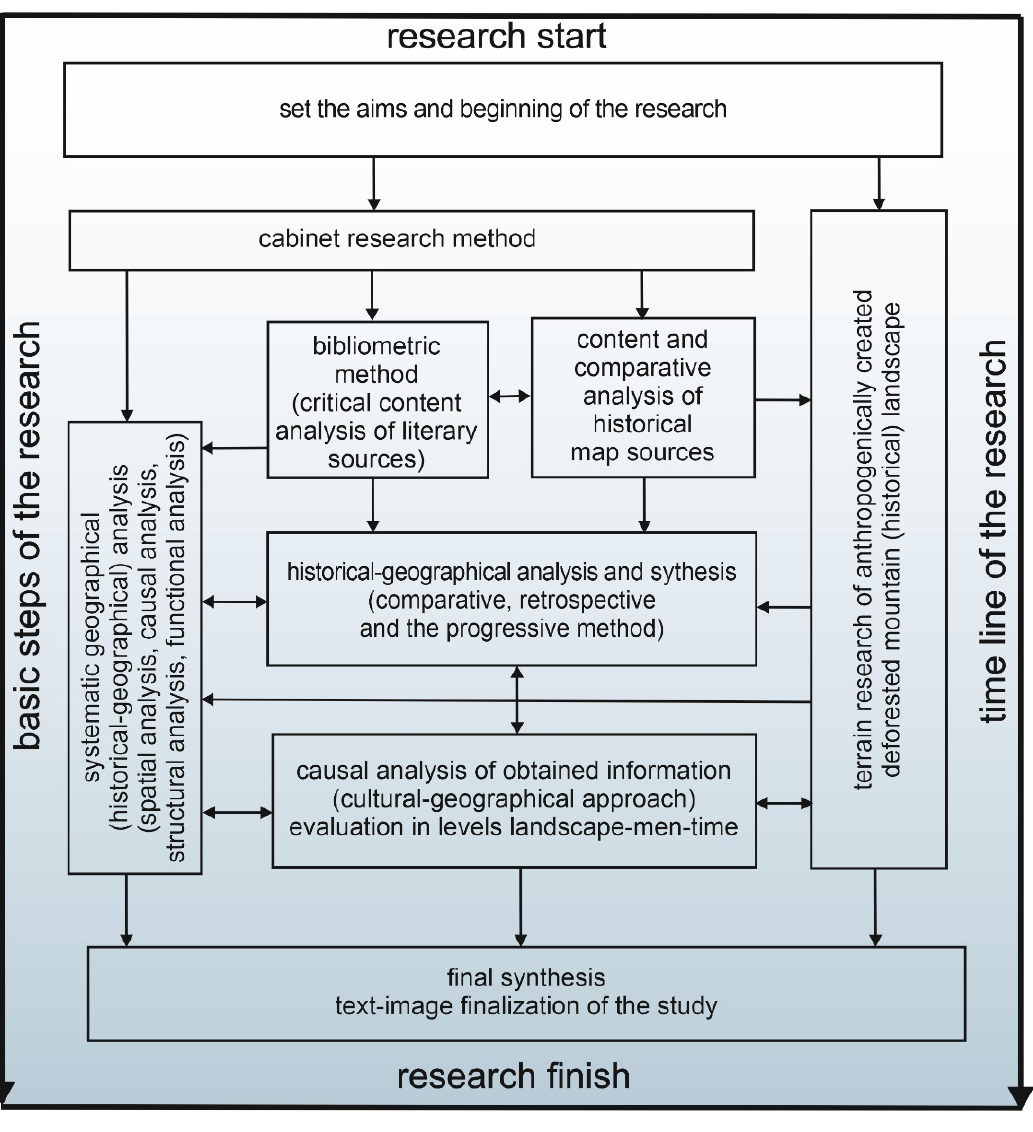
Figure 3. Schematic representation of theoretical and methodological research and work procedures (source: authors’ research).